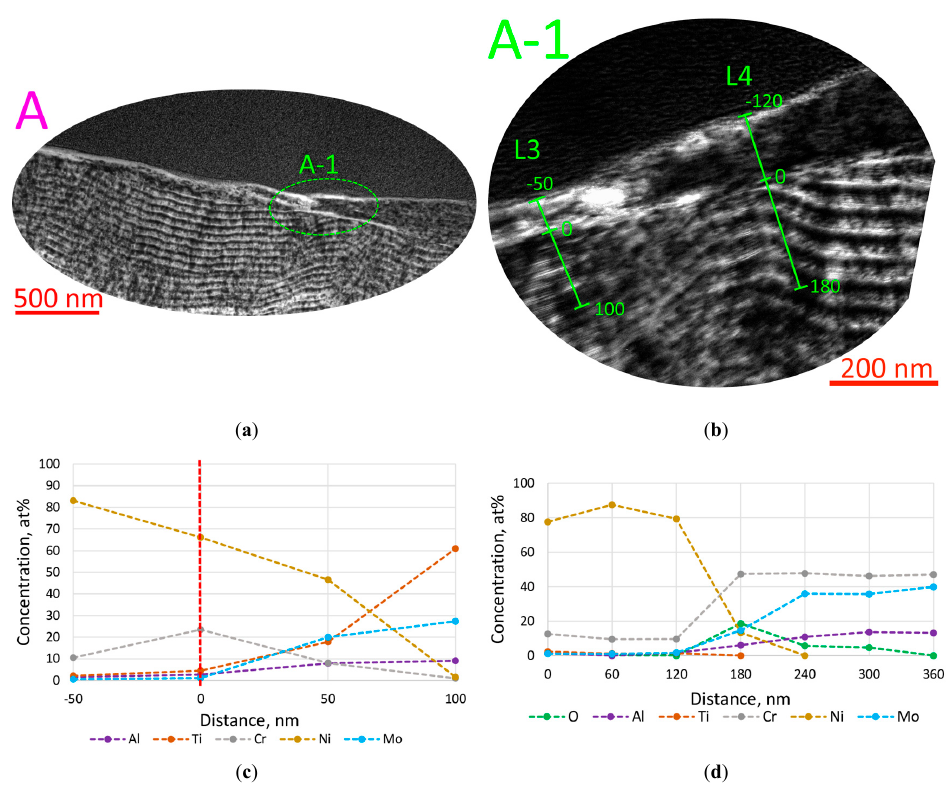
Figure 8. ( a ) General view of Area A; ( b ) localization of lines L3 and L4 for study of the elemental composition; ( c ) change in the elemental composition along line L3; ( d ) change in the elemental composition along line L4. The localization of area A is shown in Figure 7.